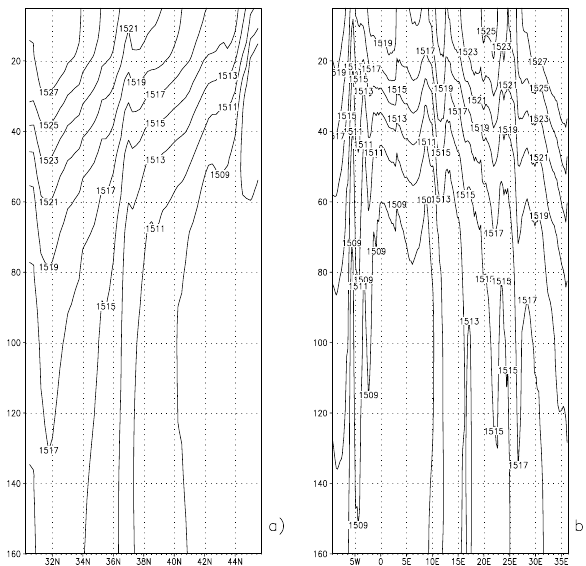
Fig. 3. Annual sound speed (m/s) between 5 and 160m: (a) zonal mean between 30.25 and 45.75 ◦ N; (b) meridional mean between 9.375 ◦ W and 36.375 ◦ E.